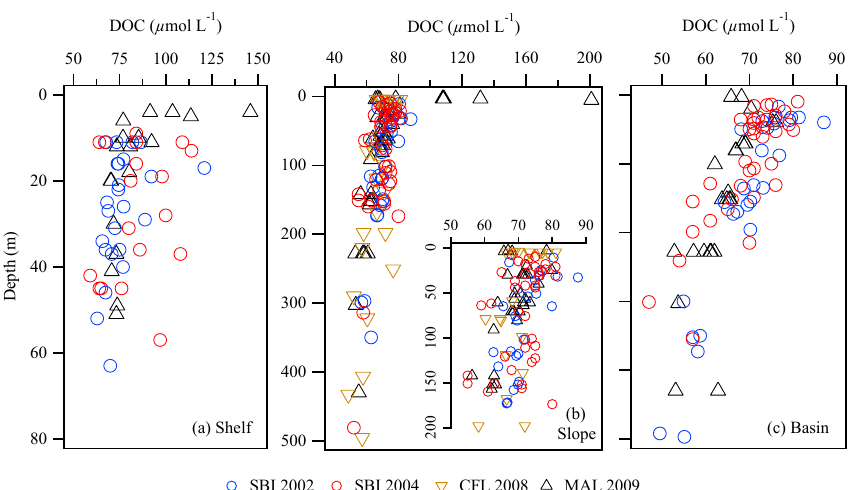
Fig. 3. Concentrations of dissolved organic carbon (DOC) in (a) shelf, (b) slope, and (c) basin waters of the Chukchi Sea (SBI 2002, SBI 2004) and Beaufort Sea (CFL 2008, MAL 2009).